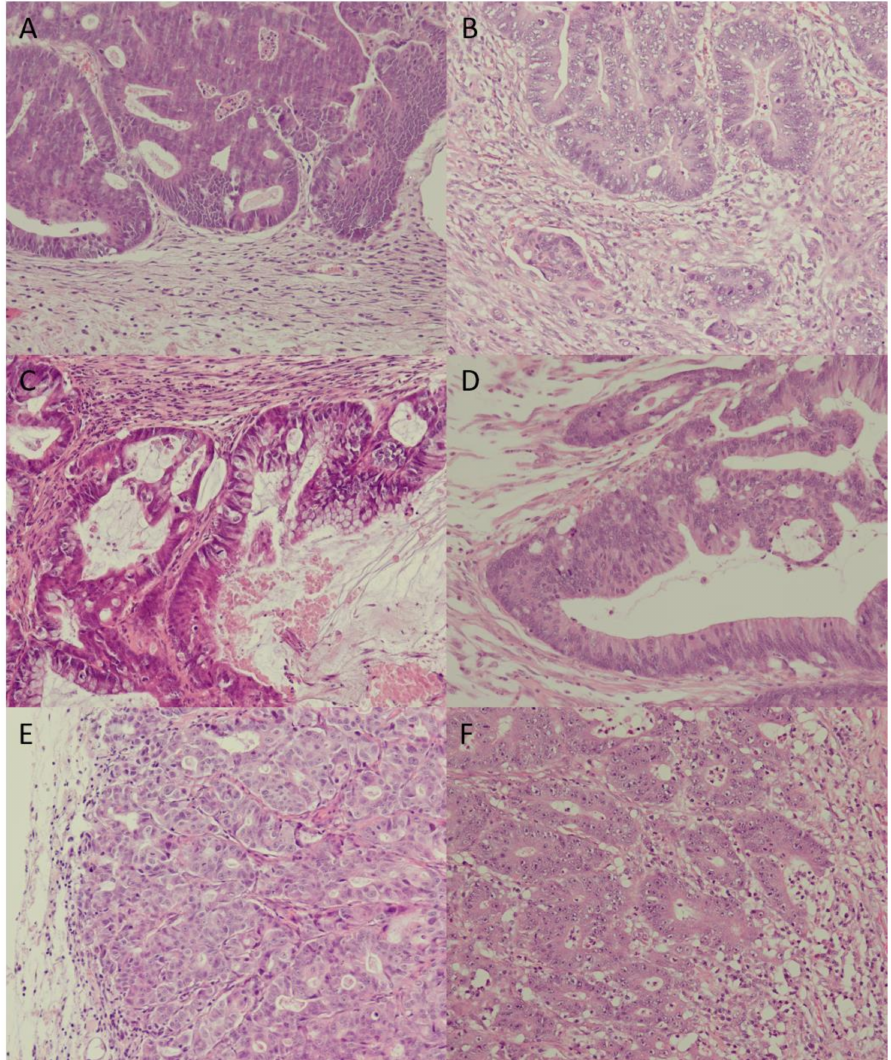
Figure 1. Comparison of primary tumor vs. PDX tumor in 20-fold magnification: ( A ) = HROC172 primary tumor, ( B ) = HROC172 T2 M2; ( C ) = HROC260 primary tumor, ( D ) = HROC260 T2 M5; ( E ) = HROC386Tu1 primary tumor, ( F ) = HROC386Tu1 T1 M1. In the case of HROC172,